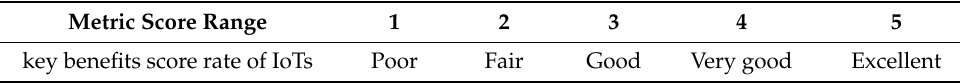
Table 1. Metric range and key benefits score rate of IoTs.